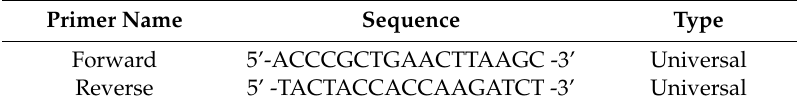
Table 1. Details of the primers used in the present